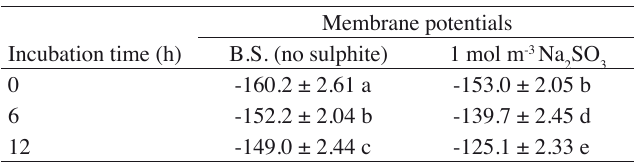
Each value is the mean ± sd of ten experiments. Different letters denote statistically significant differences between membrane potentials (P<0.01).